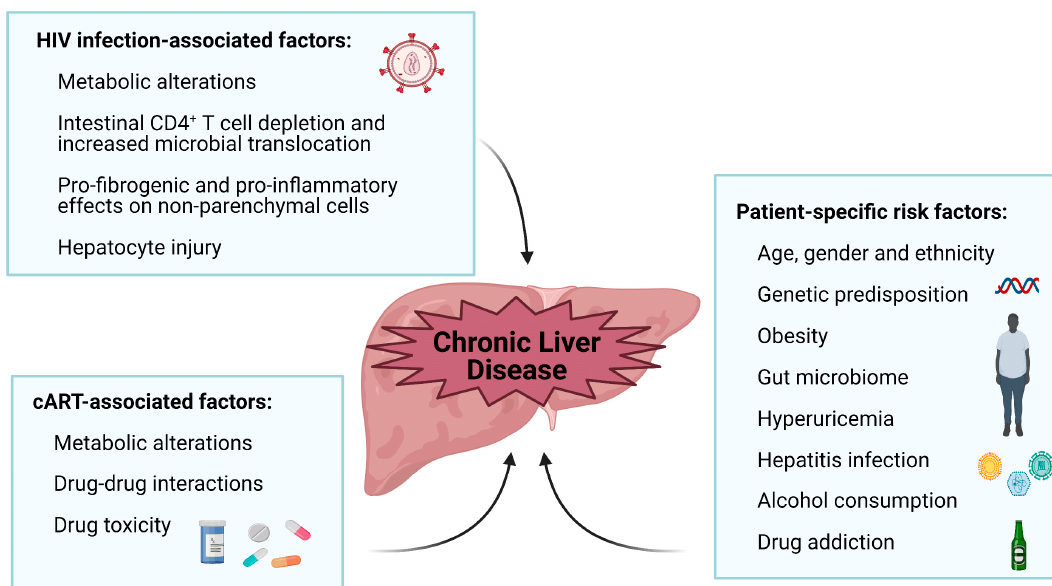
Figure 1. Factors that promote chronic liver disease in the HIV-infected population. These factors can be associated with HIV infection (direct effect of the virus on the liver that has been shown to produce metabolic alterations, increased microbial translocation, hepatocyte injury and pro-fibrogenic and pro-inflammatory effects on non-parenchymal cells) and with cART (ability of each ARV drug to induce hepatotoxicity and metabolic alterations). Furthermore, patients present specific risk factors (variations arising from patient’s sex, ethnicity and age, and other pathophysiological aspects such as alcohol consumption, obesity, viral hepatitis infection, genetic predisposition, hyperuricemia, and gut microbiome composition).